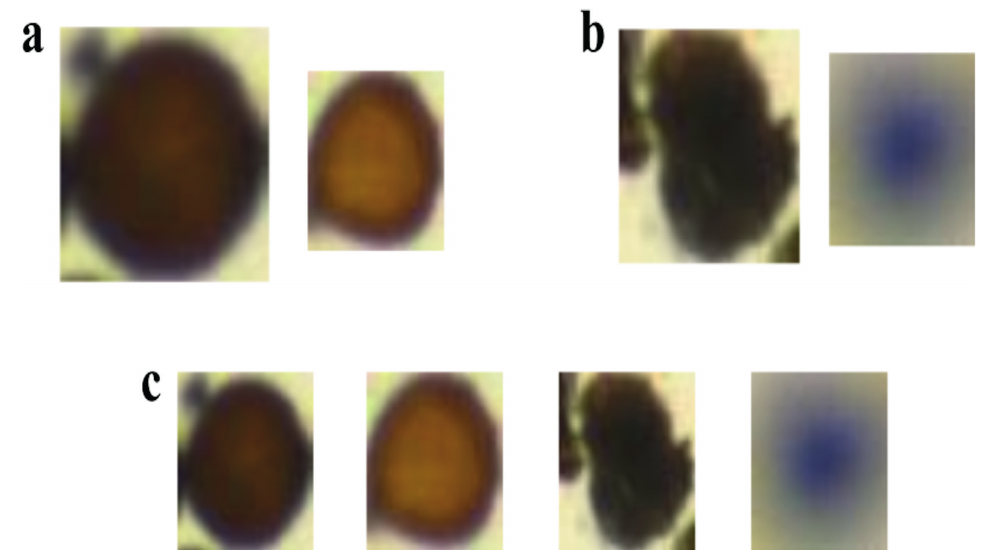
Figure 2 - Patterns found by CHT in rgB sub-images: ‘spore’ pattern in rgB sub-image ( a ); “non spore” pattern in rgB sub-image ( b ); The rgB sub-images resized ( c